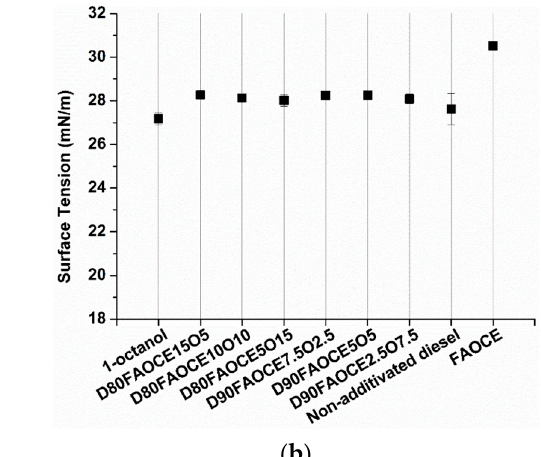
Figure 10. Surface tension values of pure components and their binary ( a ) and trinary ( b ) blends with mineral diesel.